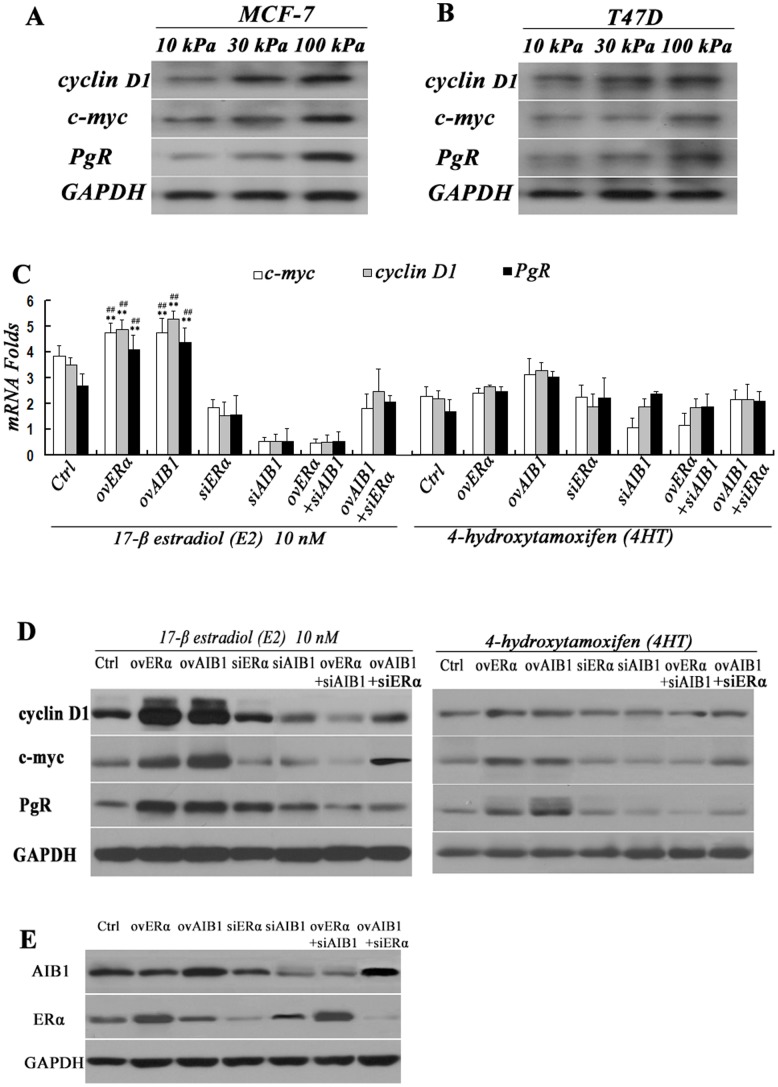
The mRNA and protein expression of the c-myc, cyclin D1, and PgR, which are co-regulated by ERα and AIB1.Western blotting for the protein expression of cyclin D1, c-myc, and PgR in MCF-7 (A) and T47D (B) cells grown on different rigidity silicone substrates for 48 h. (C) Real-time RT-PCR analysis of the mRNA expression of the c-cmy, cyclin D1, and PgR genes in siAIB1, siERα, ovAIB1, ovERα, siAIB1+ovERα, siERα+ovAIB1, and control MCF-7 cells grown on 100-kPa silicone substrate for 48 h. Data were calculated relative to GAPDH expression and are presented as mean ± SD fold-change compared with wild MCF-7 control cells (n = 3); **P<0.01, compared with control cells; ##P<0.01, compared with the siAIB1, siERα, siAIB1+ovERα, and siERα+ovAIB1 MCF-7 cells. (D) The siAIB1, siERα, ovAIB1, ovERα, siAIB1+ovERα, siERα+ovAIB1, and wild MCF-7 cells grown on the 100-kPa silicone substrate for 48 h. Crude proteins were then extracted from the cells were subjected to SDS-PAGE followed by Western immunoblot with the antibodies against c-myc, cyclin D1, and PgR. (E) The protein expression of ERα and AIB1 in siAIB1, siERα, ovAIB1, ovERα, siAIB1+ovERα, siERα+ovAIB1, and wild MCF-7 cells by Western blot.